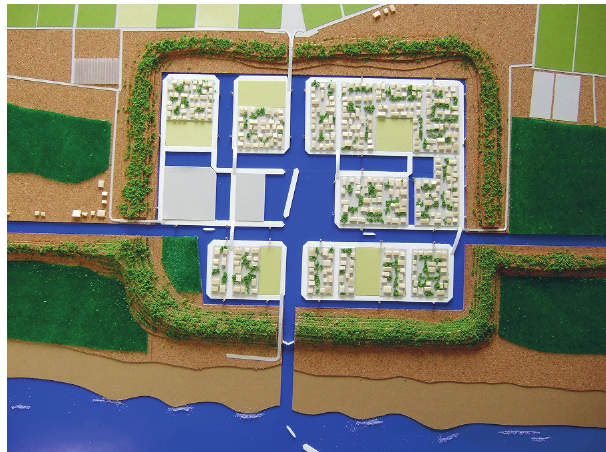
Figure 9. Satellite view of reconstructed Arahama coastal area (Image as represented by architectural